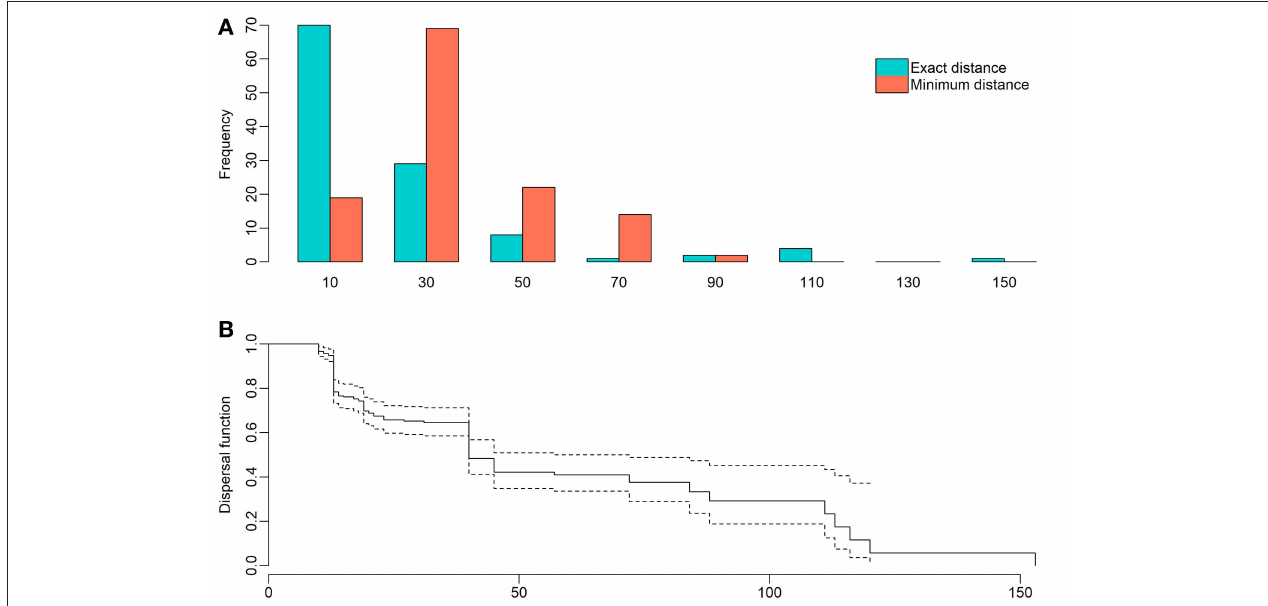
FIGURE 2 | Dispersal distances (in m) of A. bidwillii seeds transported by sulfur-crested cockatoos. (A) Distribution of the exact and minimum dispersal distances recorded ( n = 241). (B) Kaplan-Meyer estimate of the dispersal function. Dashed lines show 95% confidence